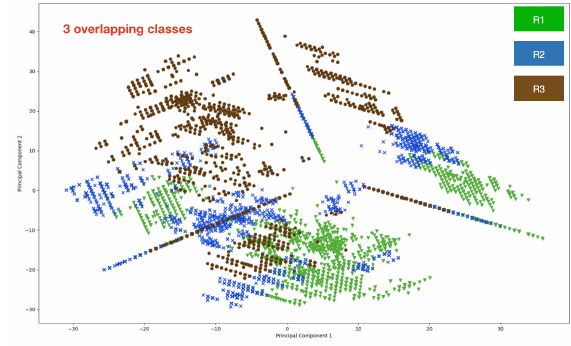
Figure 3. Scatter plot showing RSSI measurements with no data preprocessing divided into three